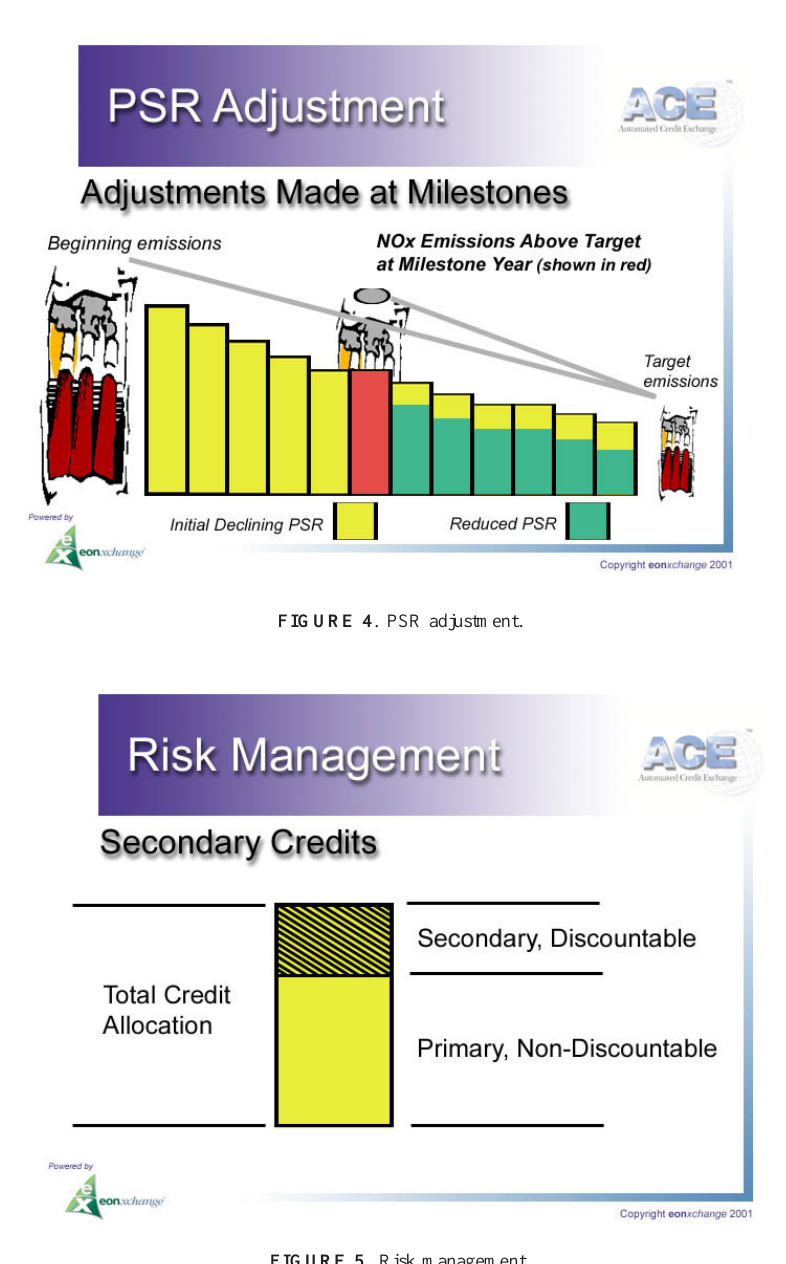
FIGURE 3. Actual emissions vs. facility allocation.